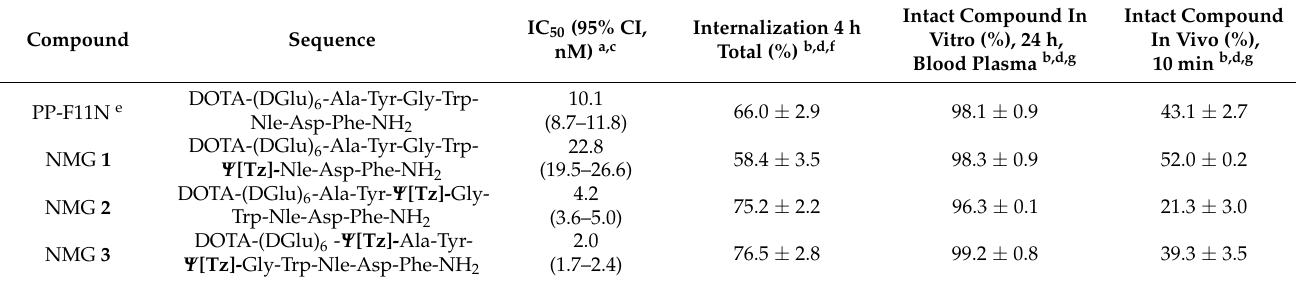
Table 1. Physio-chemical properties of (radio)metal labeled NMGs in comparison with PP-F11N.